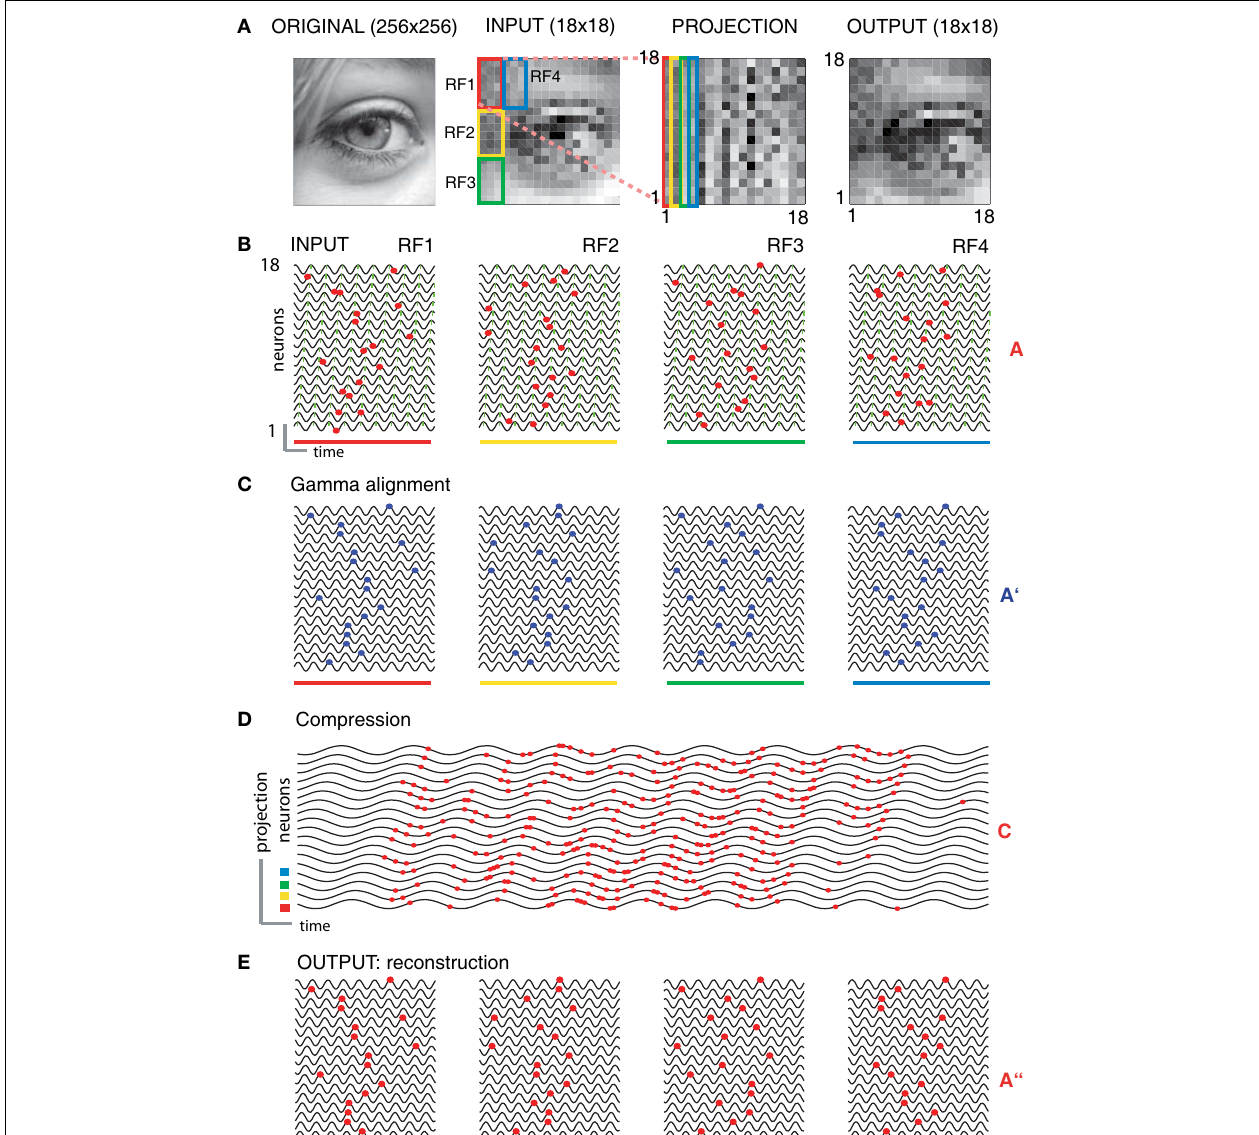
aligned to the nearest subsequent maxima of the local SMO oscillation (blue markers). (D) The spatiotemporal pattern of APs from each group was collapsed into a single sequence and combined in 18 AP sequences (red markers) to transfer through projection neurons. The sinusoid traces correspond to the fi rst neuron’s SMO of a given receptive fi eld in (C) . The fi rst four traces correspond to the RFs on (A) . (E) Reconstruction of the information from the compressed code in (D) . The interference between the input and the neuron’s intrinsic SMO peaks generated patterns (red markers) that reproduced the original gamma- aligned patterns. To compare the reconstruction with the original input, we converted the AP latencies from all the neurons to gray level pixels ( A ; fourth panel). Note that the reconstruction of the original phase relationship between the APs and local SMO is near perfect ( C,E and A fourth panel). we estimated the speed of SMO propagation ( v ) and the diameter ( d ) of the cortical cylinder that would be covered by a radial wave of a single SMO cycle of f frequency and v speed. Assuming that ≈ 40 Hz and T ≈ 12.5 ms, and applying v = Δ x / ΔΦ f π gamma